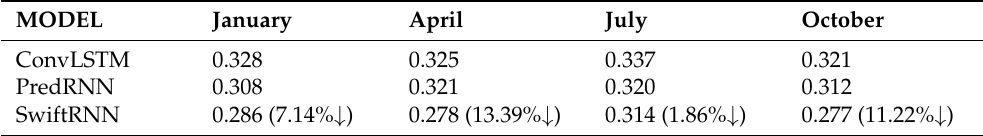
Table 4. Same with Table 3, but for LPIPS metric.